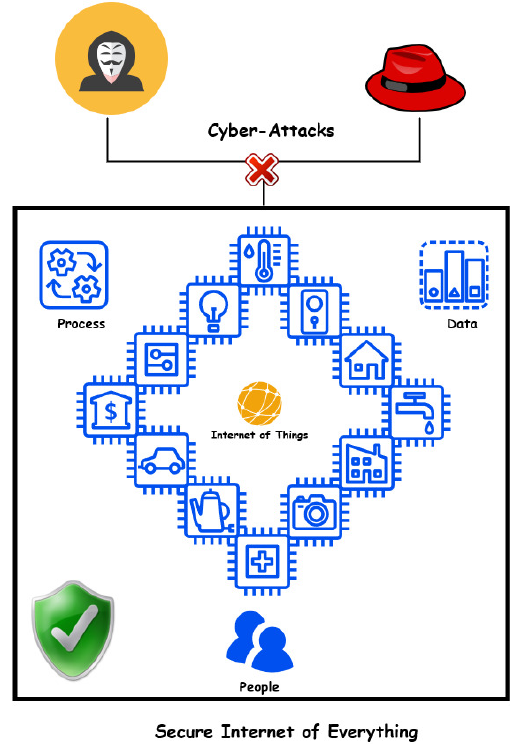
Figure 2. Security in Internet of